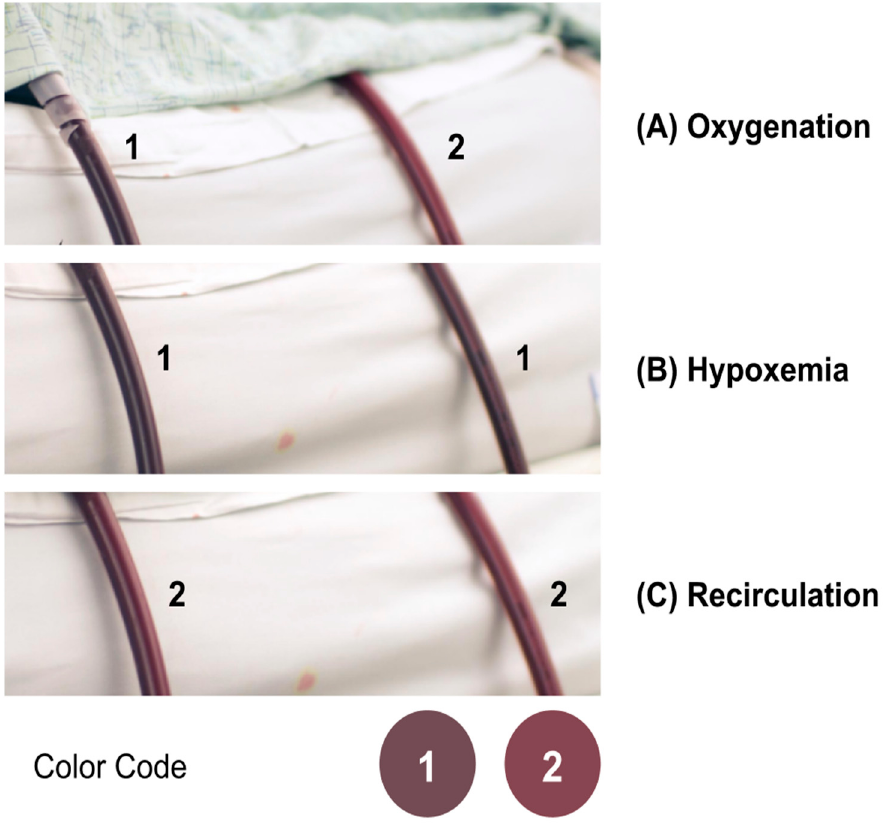
Figure 11. Simulating ( A ) oxygenation, ( B ) deoxygenation, and ( C ) recirculation using a simulated ECMO circuit.